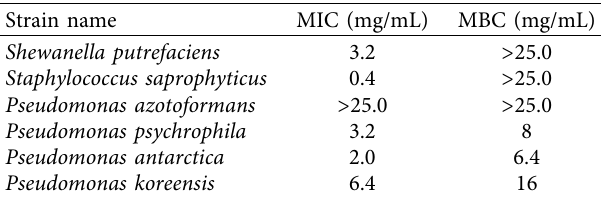
Table 2: MIC and MBC of DMY against specific putrefactive bacteria of hybrid